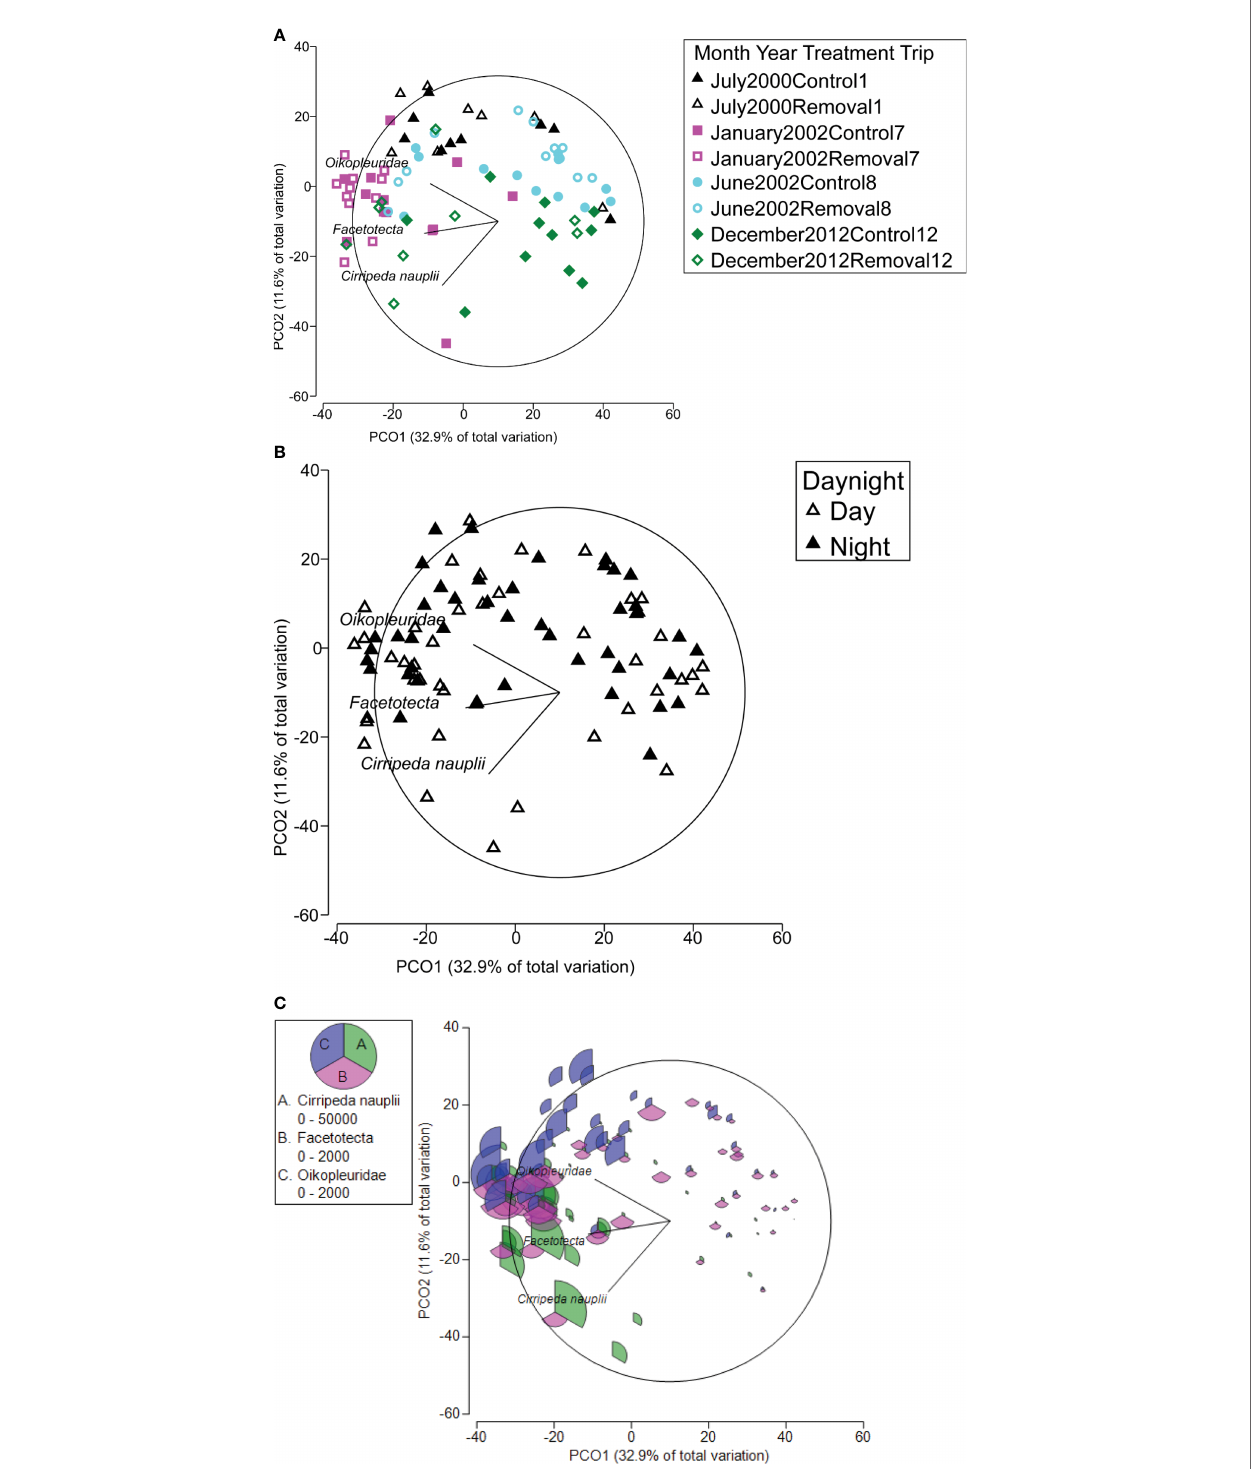
FIGURE 4 | Principal coordinates analysis (PCO) ordination plot of zooplankton abundance composition per emergence trap (1 m -2 ) showing vectors for the three taxa that contributed the most to the dissimilarity (taxa with Pearson ’ s correlations > 0.5), labelled by the factors (A) cleaner fi sh Labroides dimidiatus presence treatment (Control = yes cleaner fi sh present, Removal = no cleaners present) per trip and (B) time of day (day and night) and with (C) segmented balloons representing the relative abundance of above three taxa. Key shows range in abundance per taxa. Data were square root transformed and a Bray-Curtis similarity was calculated for the